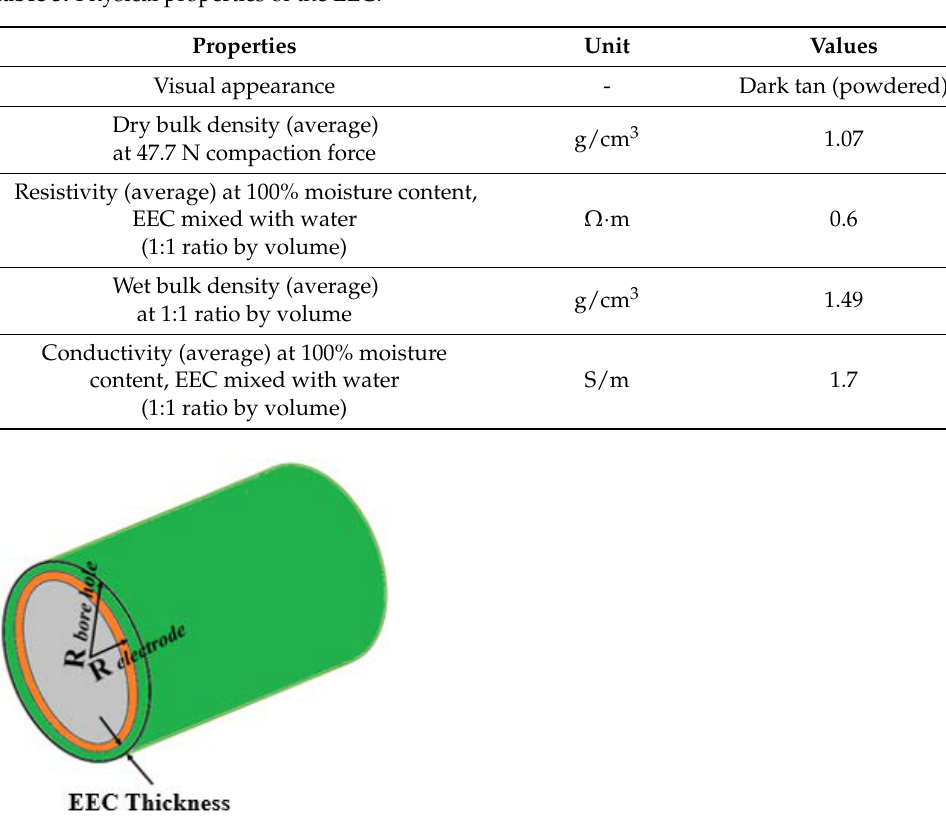
Table 3. Physical properties of the EEC.